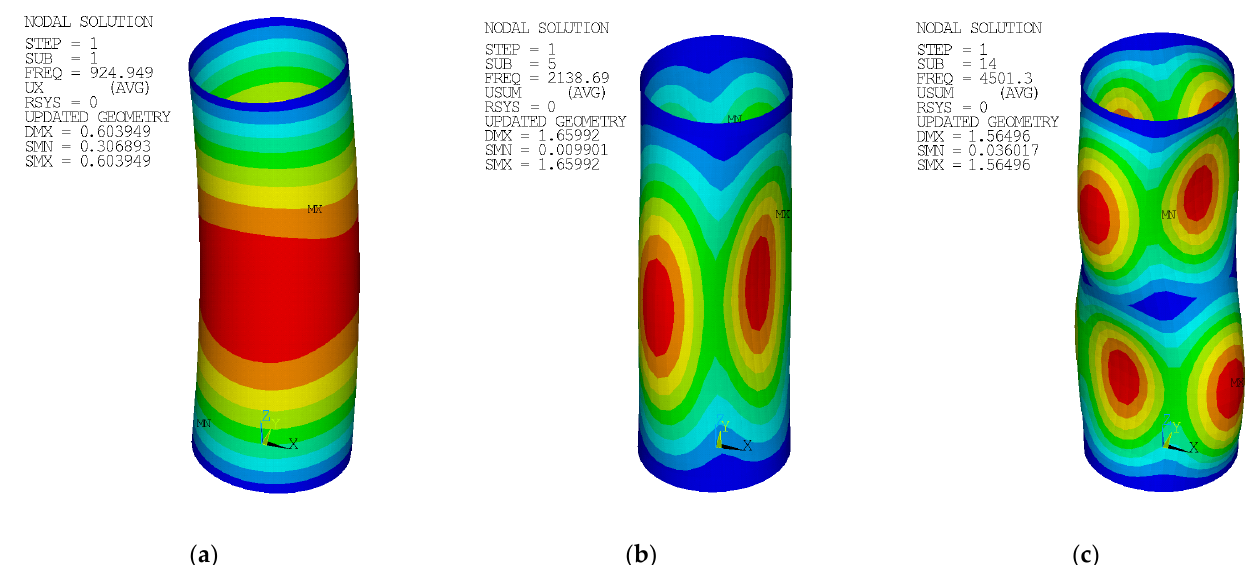
Figure 2. Example of the modal analysis results (geometry of 88.9 × 2.6-400-P) [38]: ( a ) Modal shape (displacements in the x-axis direction) for global imperfection; ( b , c ) Modal shapes (total displacement) to determine the local imperfection.